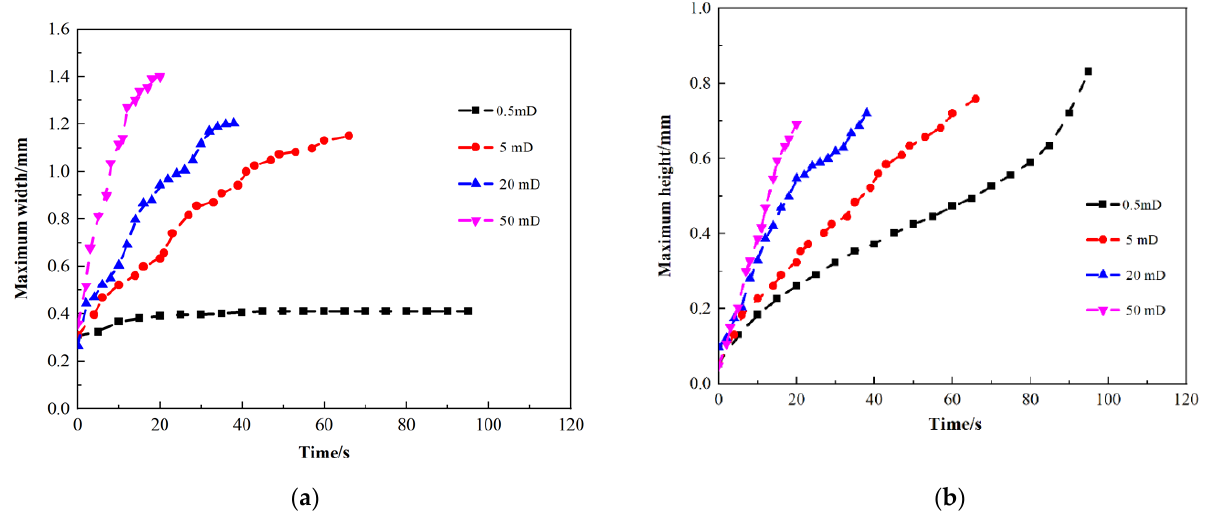
Figure 10. Change of oil drop size on core chips with different permeability. ( a ) Comparison of maximum width of oil drop; ( b ) Comparison of maximum height of oil drop.